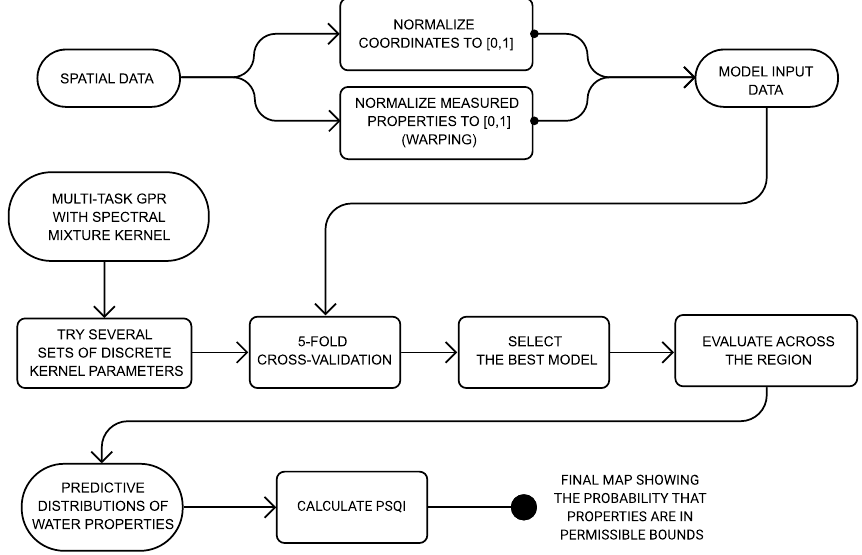
Figure 1. Main steps of the workflow: from data pre-processing to final Probabilistic Substance Quality index